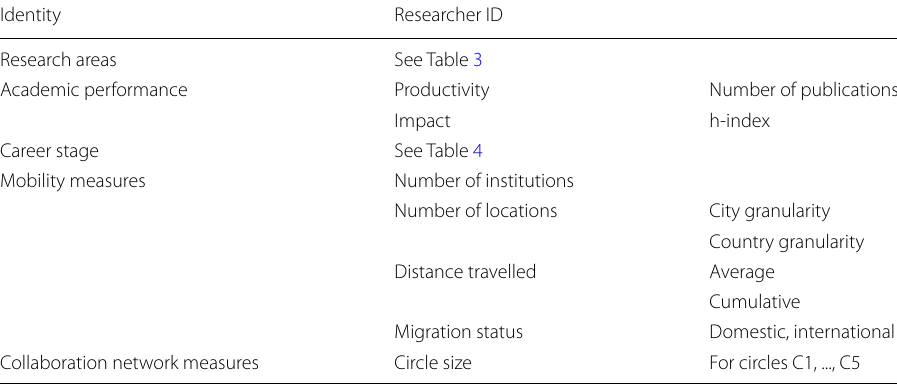
Table 2 The researcher profile